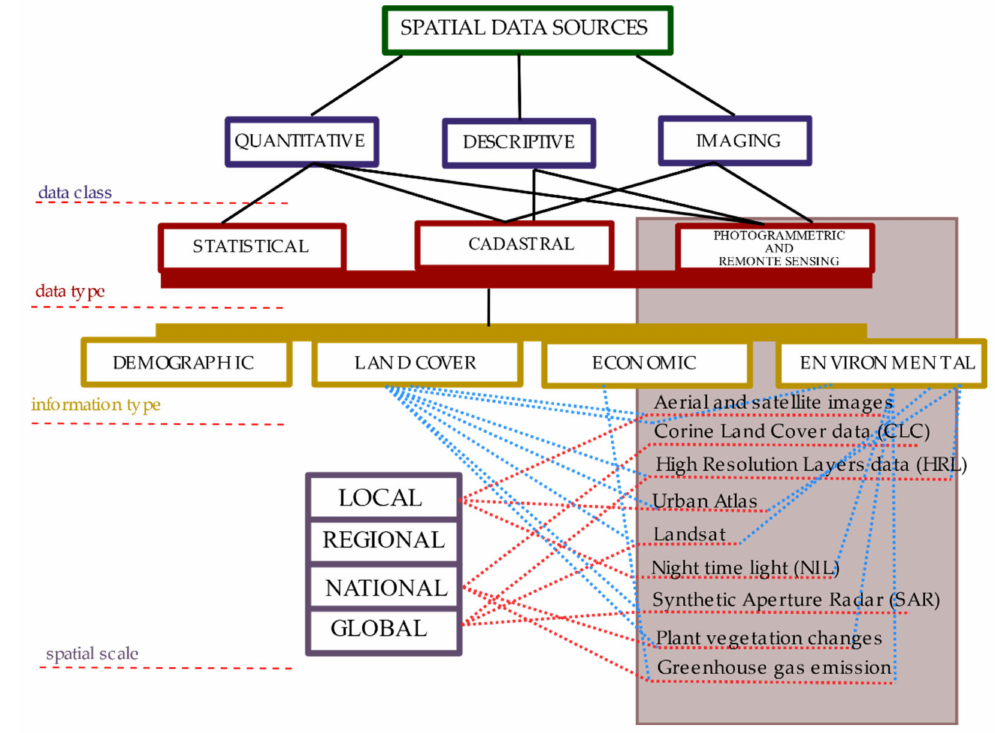
Figure 5. Classification of spatial data